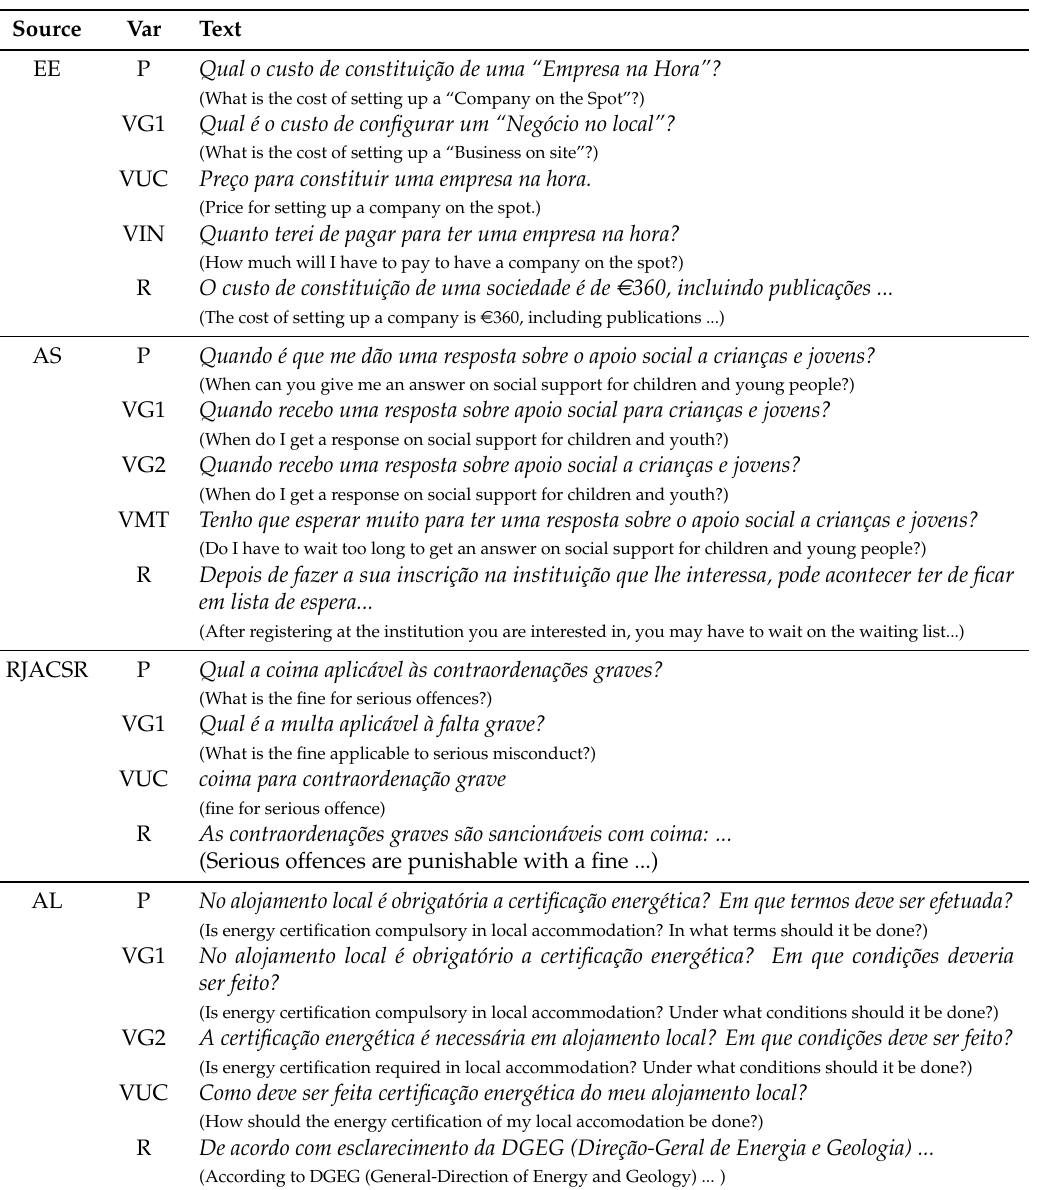
Table 1. Examples of the AIA-BDE